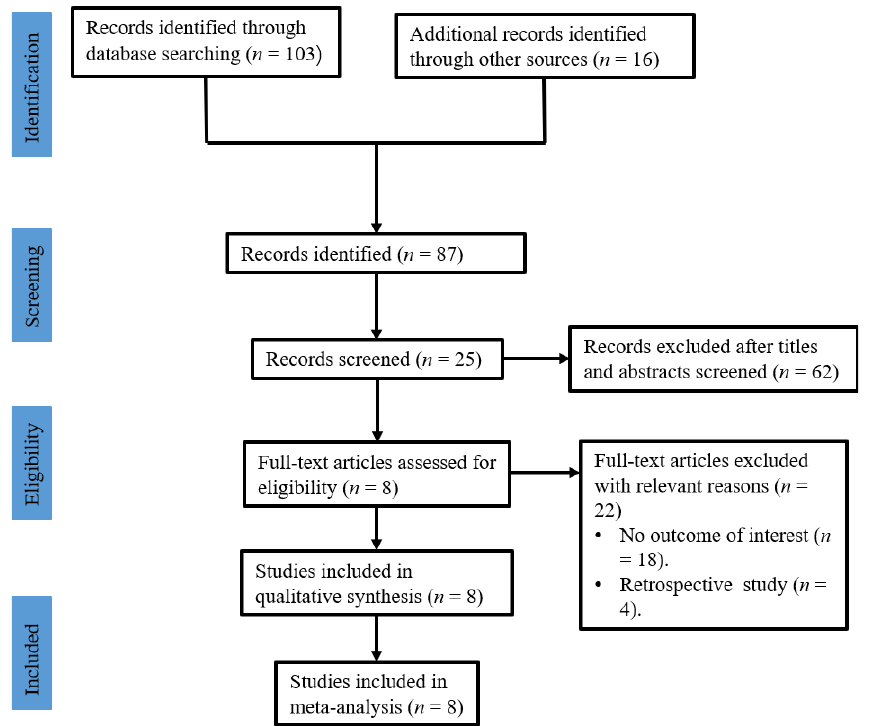
Figure 1. The flow diagram of this study.